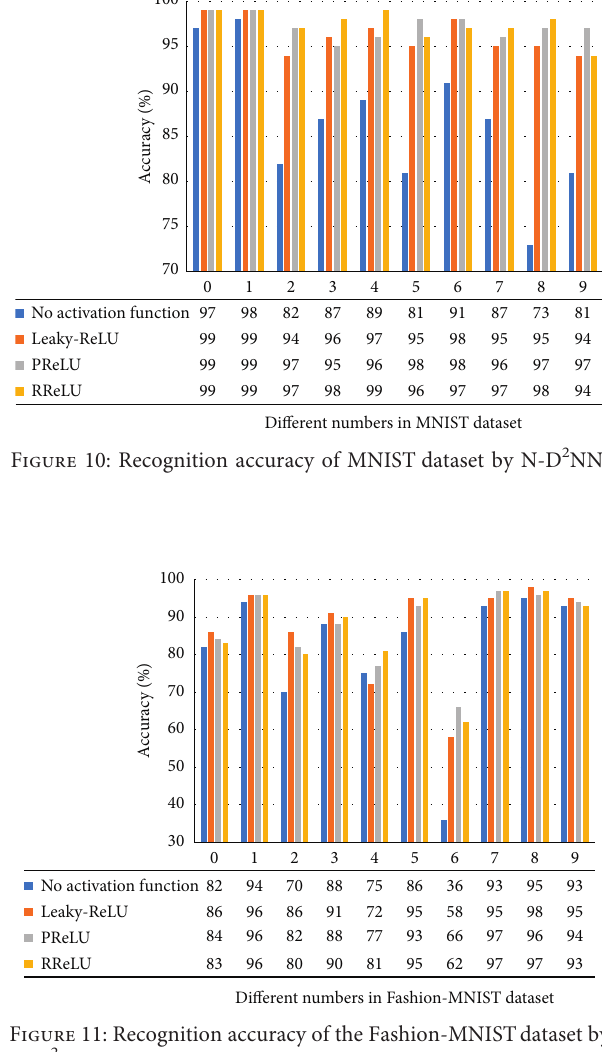
Figure 11: Recognition accuracy of the Fashion-MNISTdataset by N-D 2